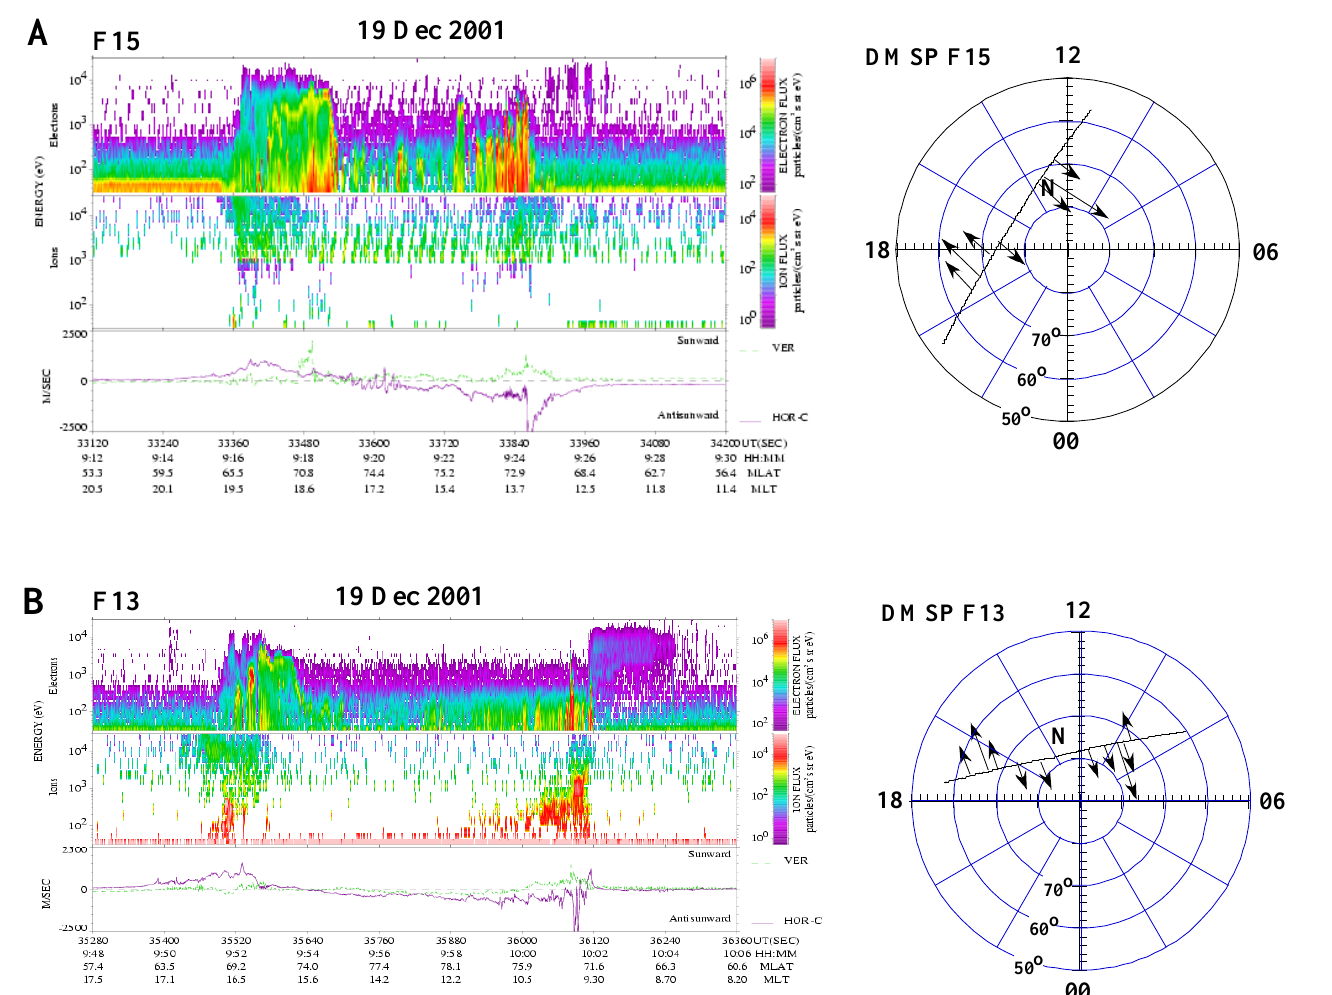
Fig. 2. DMSP F13 and F15 measurements including spectrograms for ( a ) electrons, ( b ) ions, and ( c ) horizontal and vertical drifts. At the right of each data set, the polar dial indicates the trajectory. The afternoon auroral zone crossing is later in local time than the cusp in each case. F13 remains poleward of cusp and mantle fluxes until just before crossing the morning side cusp near 09:30 MLT. The horizontal drift is strongest on the morning side as expected for this positive IMF B Y condition. Cusp fluxes are seen near 10:00 MLT just before the convection reversal. F15 skimmed the post noon cusp region observing bursts of electrons between 13:00 and 14:00 MLT. Note that the ion sensor on this spacecraft did not function below